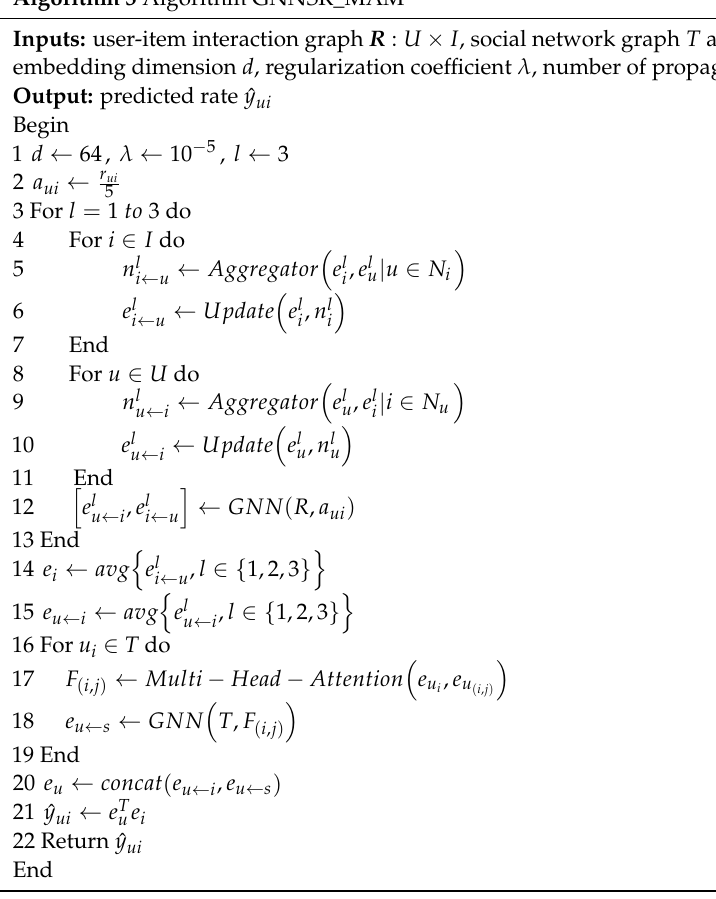
Algorithm 3 Algorithm